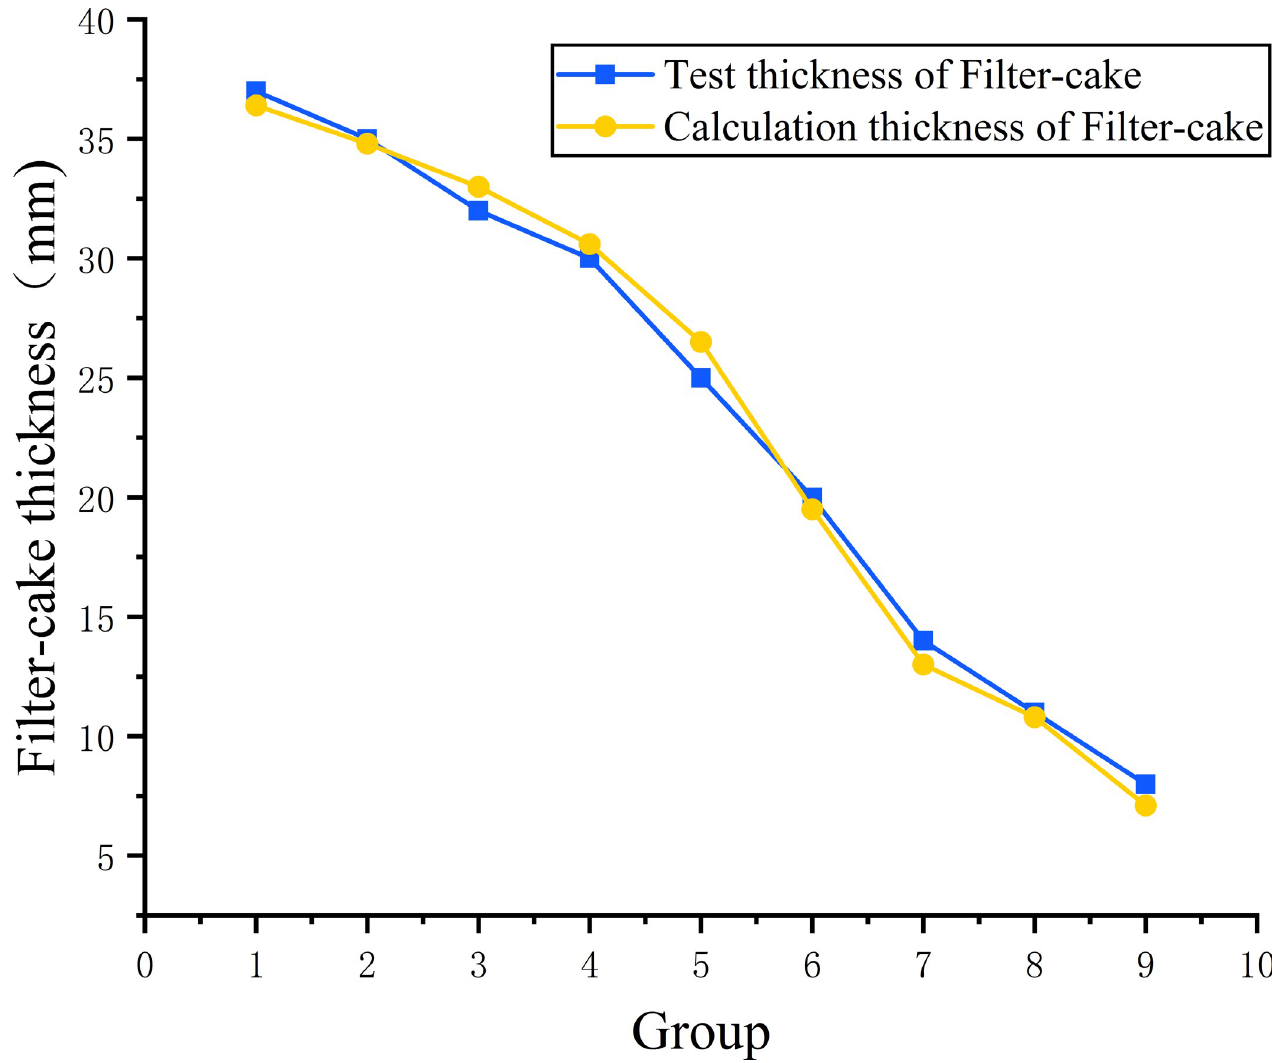
Fig 12. Comparison between the theoretical and experimentally obtained mud film thicknesses.